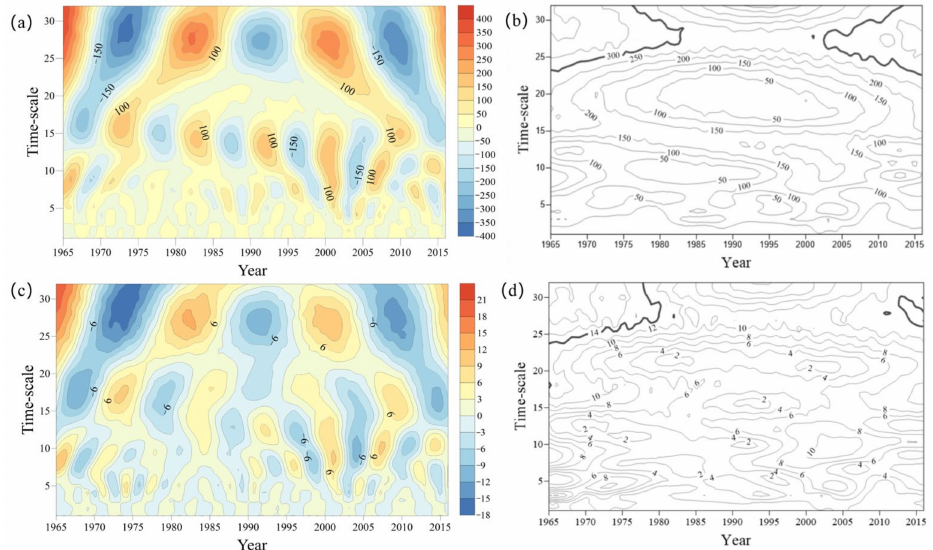
Figure 2. ( a ) Real part of rainfall wavelet transform coefficients; ( b ) Square of rainfall wavelet transform coefficient mode; ( c ) Real part of runoff wavelet transform coefficients; ( d ) Square of rainfall wavelet transform coefficient